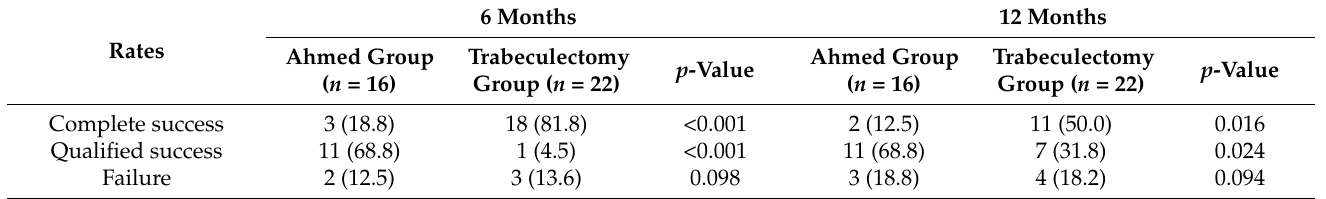
Table 2. Comparison of postoperative complete success rate, qualified success rate, and failure rate, between the Ahmed and trabeculectomy groups.